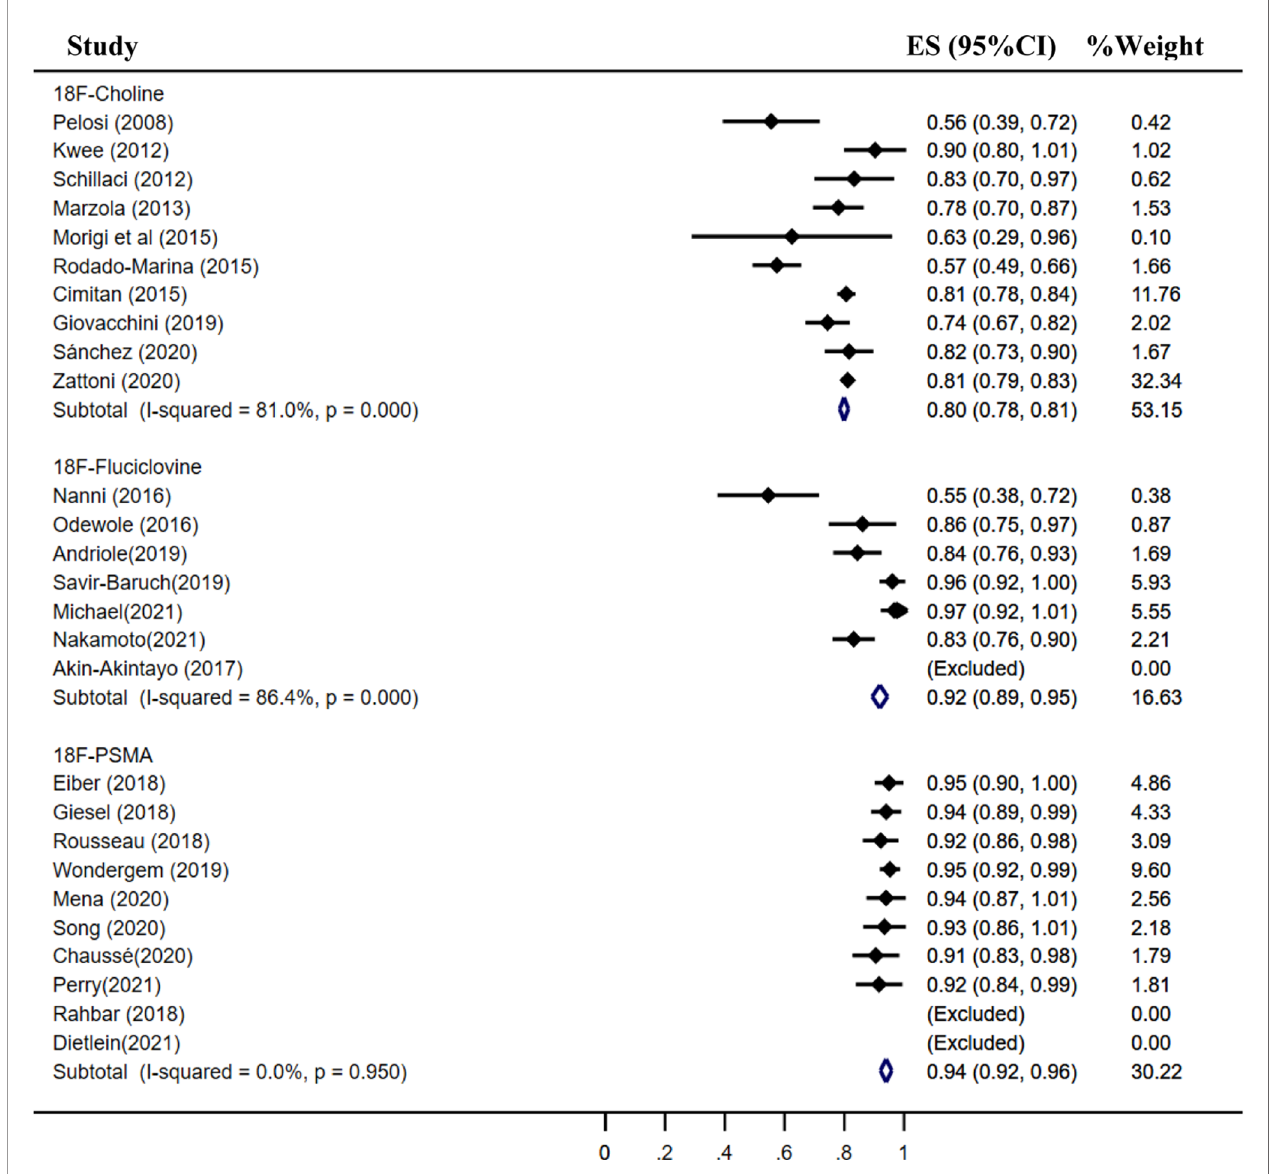
FIGURE 10 | Forest plot of the proportion of 18 F-labeled choline, fl uciclovine, and PSMA positivity of prostate cancer patients with BCR for PSA more than 2.0